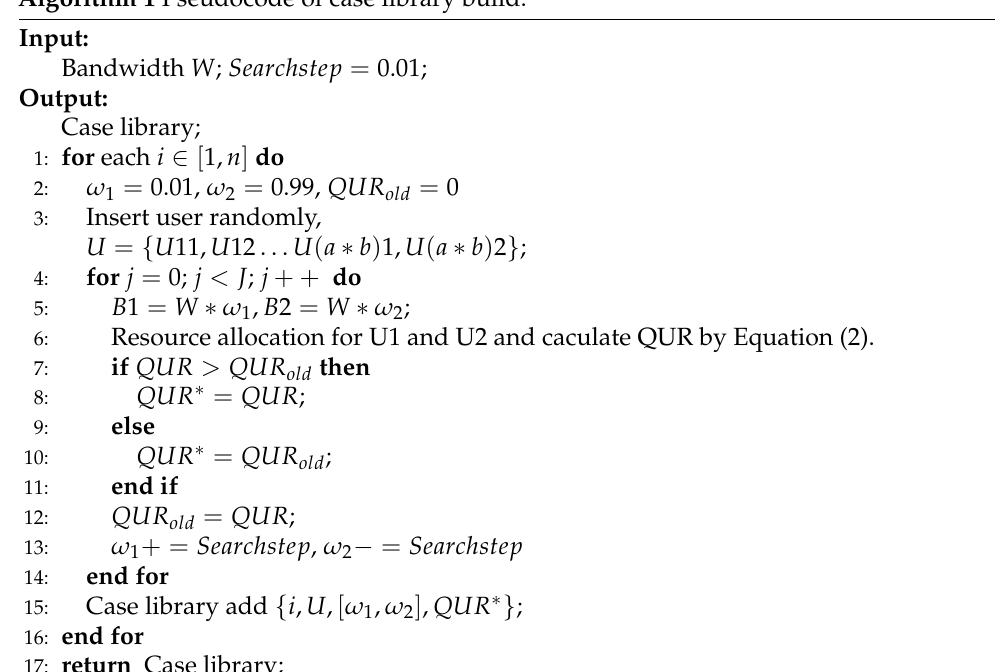
Algorithm 1 Pseudocode of case library